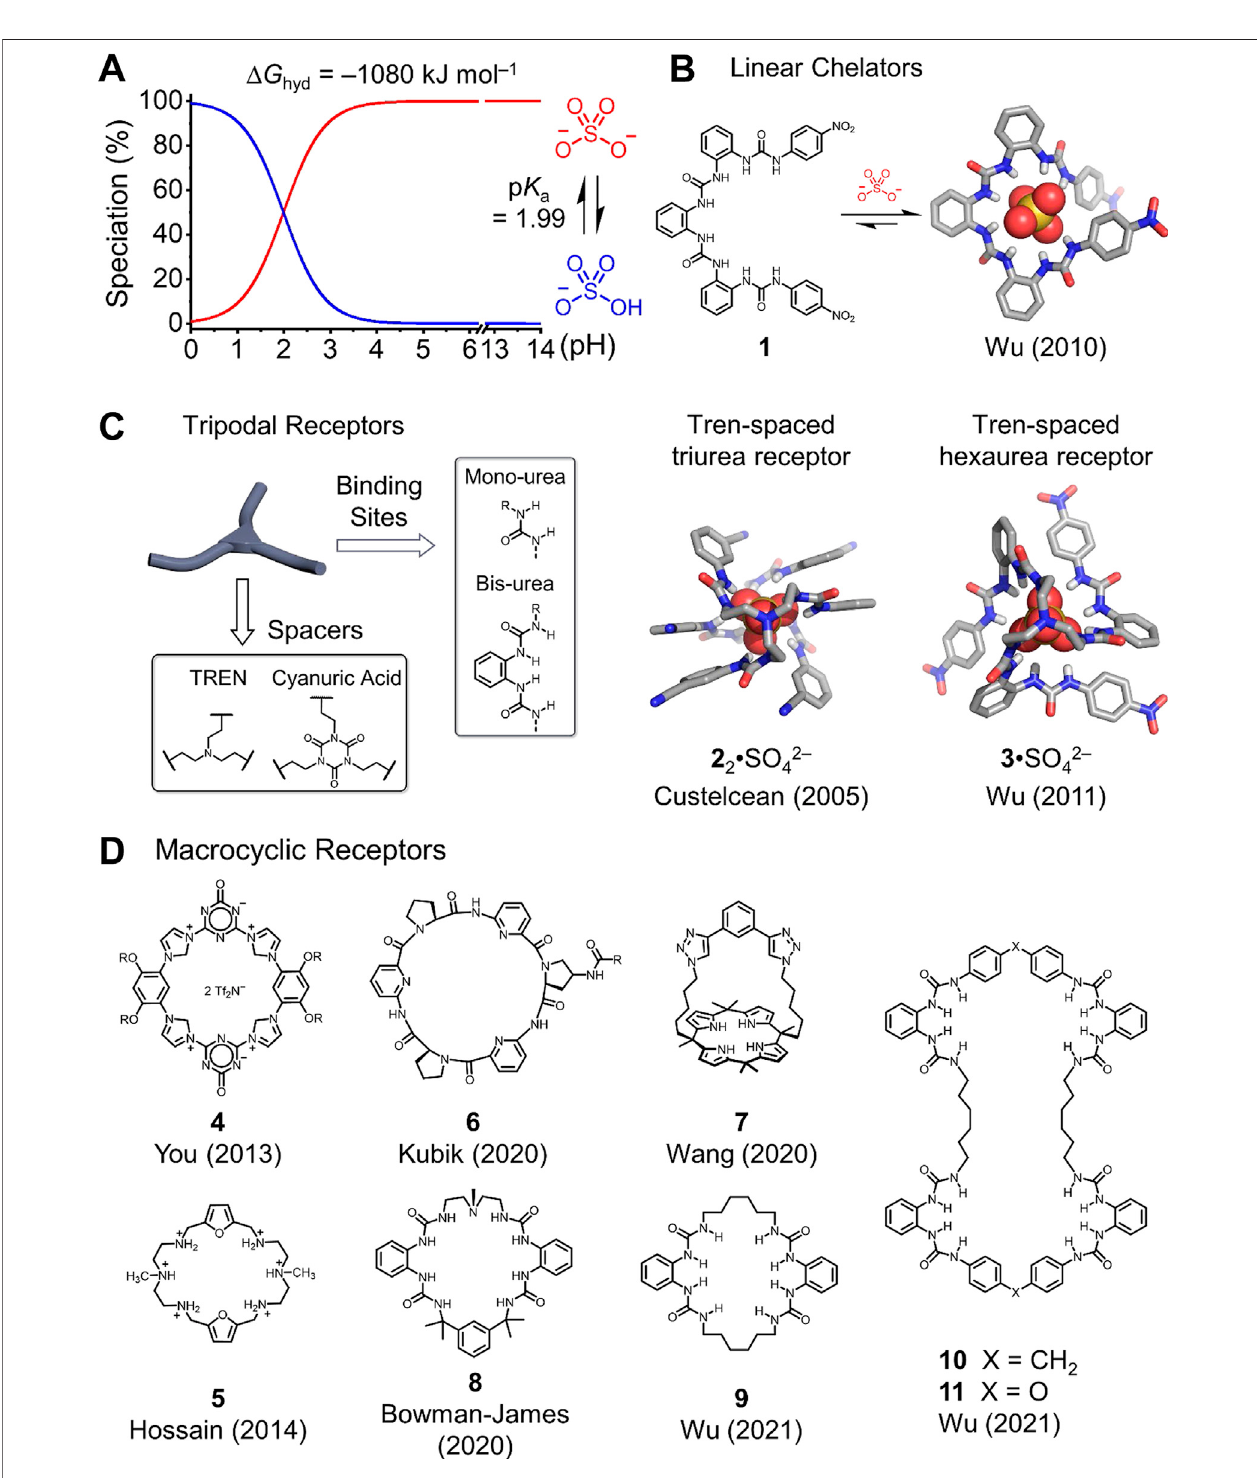
FIGURE 1 | (A) pH-dependent nature between sulfate and bisulfate anions and representative receptors developed recently for sulfate recognition: (B) linear receptor, (C) tripodal receptors, and (D) macrocyclic receptors.